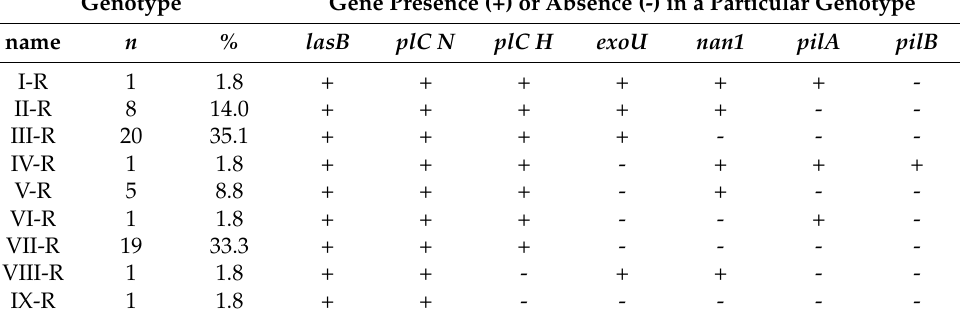
Table 2. Characteristics and distribution of the genotypes detected amongst the examined multidrug- resistant P. aeruginosa strains ( n =